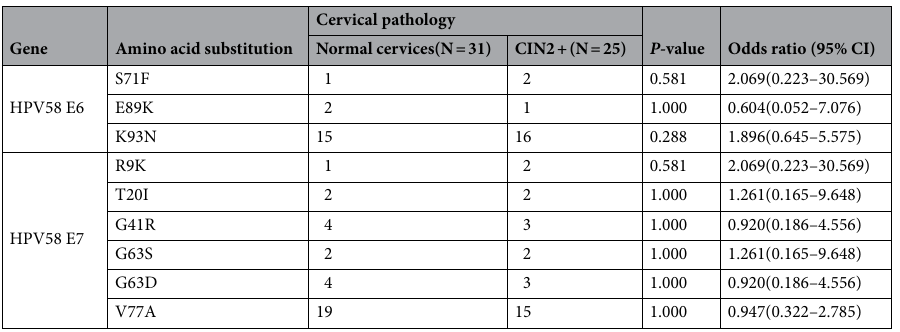
Table 6. Analysis on the oncogenic risk association of HPV58 E6 and E7 amino